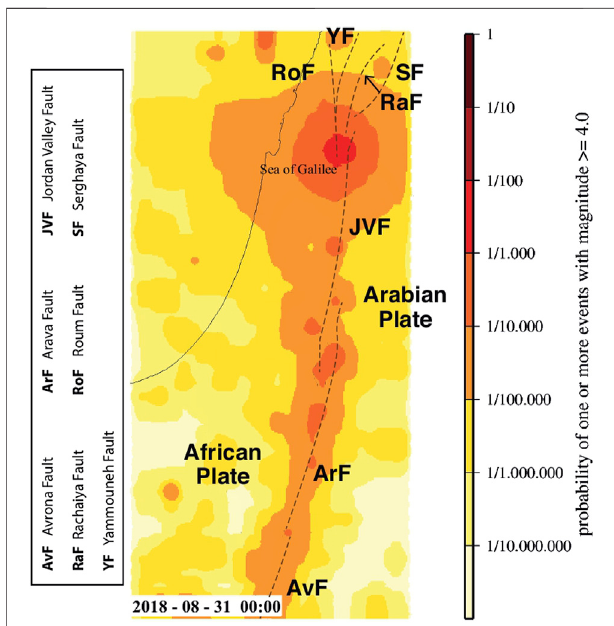
FIGURE 4 | Probability map (gridded on a lattice of 0.1 ° × 0.1 ° cells) of one or more events with M w ≥ 4.0 to occur in the week starting from August 31, 2018 at 00:00 UTC. The dashed lines indicate the faults involved in the analyzed area and the names of the plates are also included; see also Figure 2